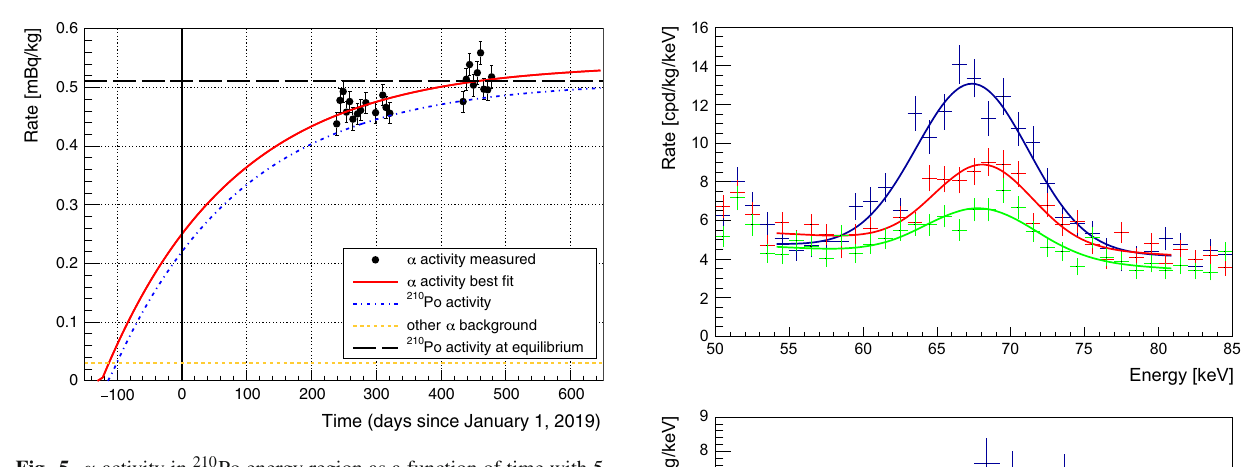
Fig. 5 α activity in 210 Po energy region as a function of time with 5- days binning. The best fit function to the data (red solid line) is the sum of the build-up function with the mean life of 210 Po (blue dotted line) and a constant component independently determined (orange dotted line). The black dashed line shows the activity of 210 Po at equilibrium